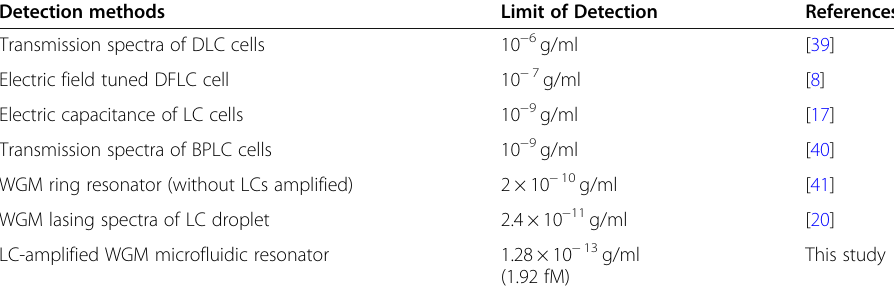
Table 1 Comparison on LOD of LC based sensing systems in detecting BSA Detection